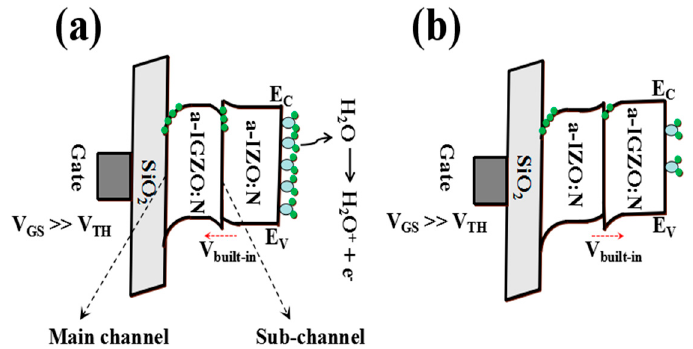
Figure 7. The energy band diagrams for ( a ) a-IGZO:N/a-IZO:N TFT (Sample I) and ( b ) a-IZO:N/a-IGZO:N TFT (Sample II), when V GS >> V TH .